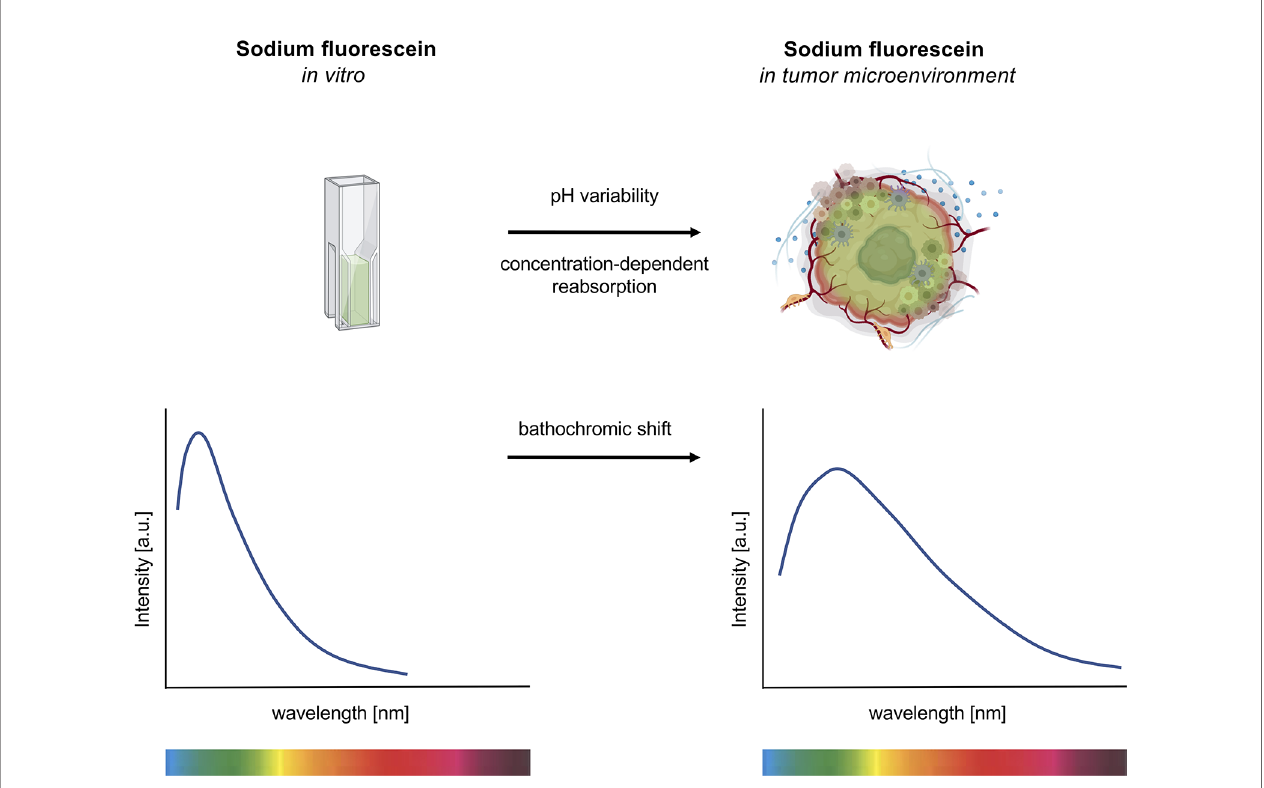
FIGURE 5 | Emission spectroscopy of sodium fl uorescein (NaFl) under in vitro and ex vivo conditions. Exposure of NaFl to the tumor microenvironment shows a broadening and a bathochromic shift of the dye ’ s emission spectrum. The pH sensitivity and the concentration-dependent reabsorption effect of the dye contribute to this red